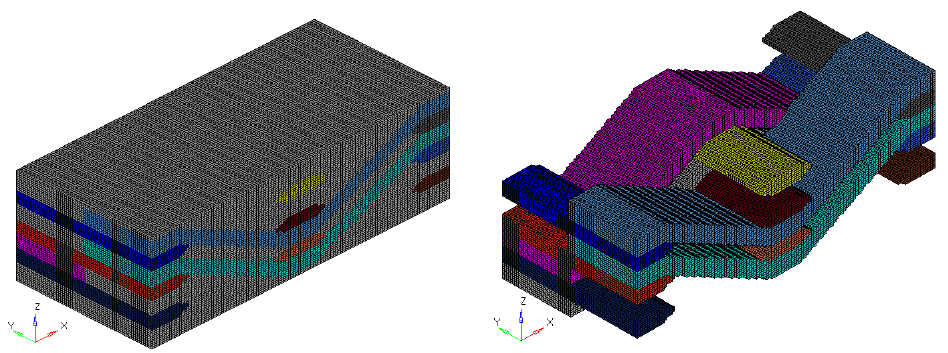
Figure 11. The finite element mesh for microstructure of 2.5D.